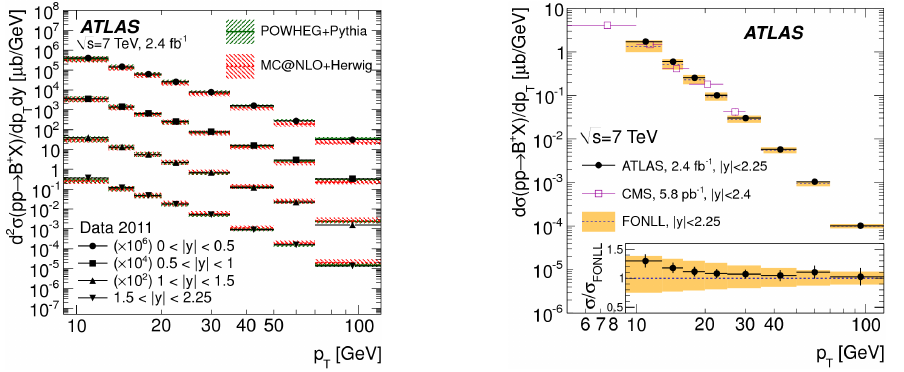
Figure 12: The doubly-di ff erential cross-section for B + production as a function of p T and y (left). The di ff erential cross-section for B + production versus p T , integrated over rapidity, compared with predictions using the FONLL calculation with a hadronization fraction f b → B + of (40 . 1 ± 0 . 8)% (right).